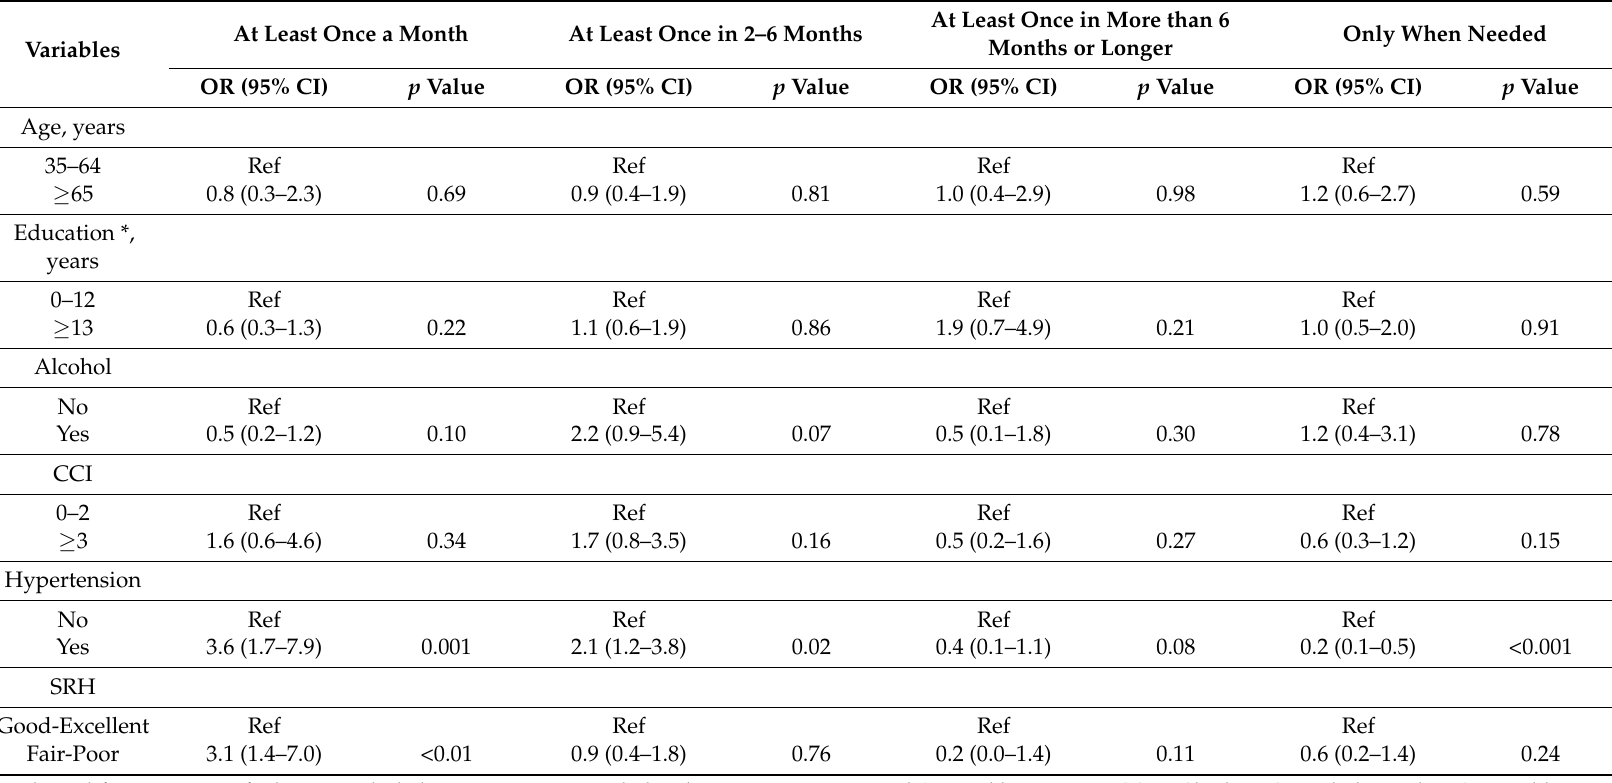
Table 4. Multivariate logistic regression analyses for the association between GP visit frequency and sociodemographic characteristics, clinical risk factors, high BP perception and SRH